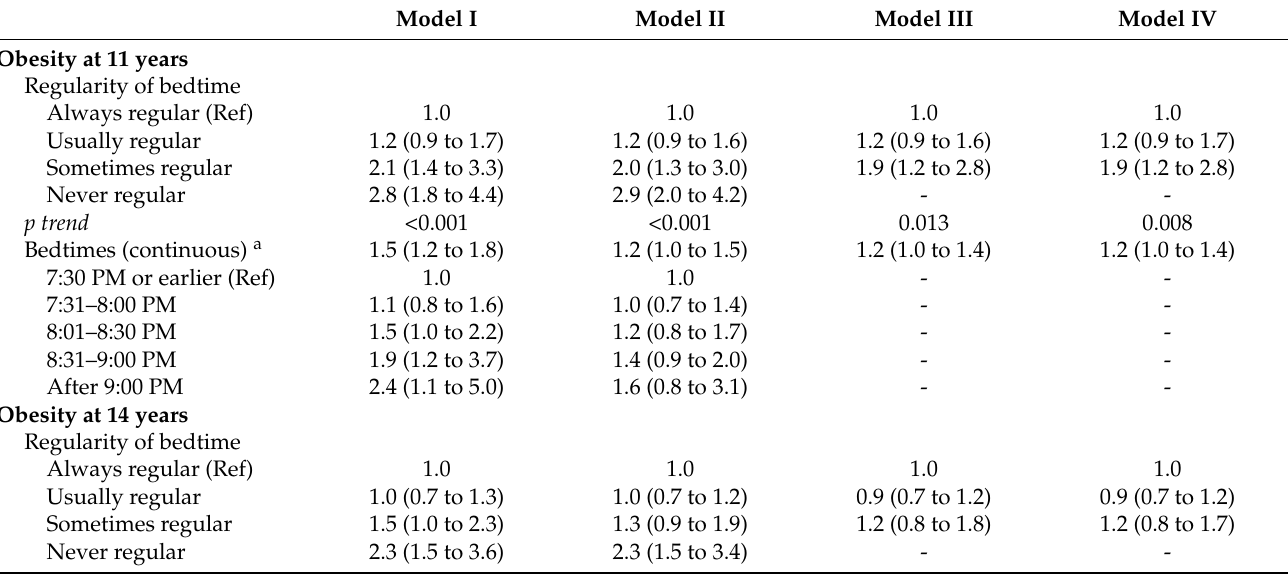
Table 2. Risk ratios (95% CI) of obesity at age 11 and 14 years by bedtime regularity and bedtimes at 7